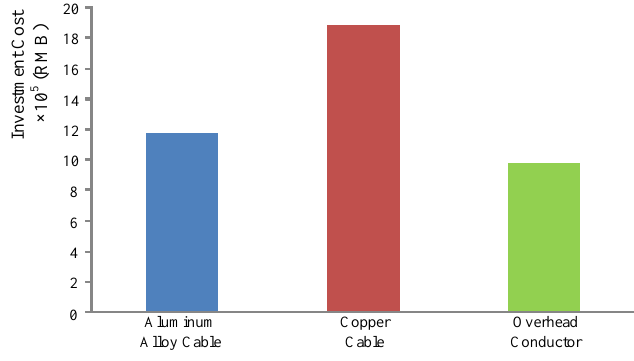
Figure 8. Investment cost during 30 years in Case